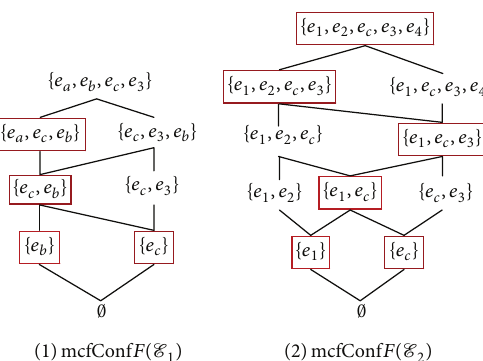
Figure 5: Families of configurations of 𝑚𝑐𝑓𝐸𝑆𝑠 ( E 1 and E 2 ).